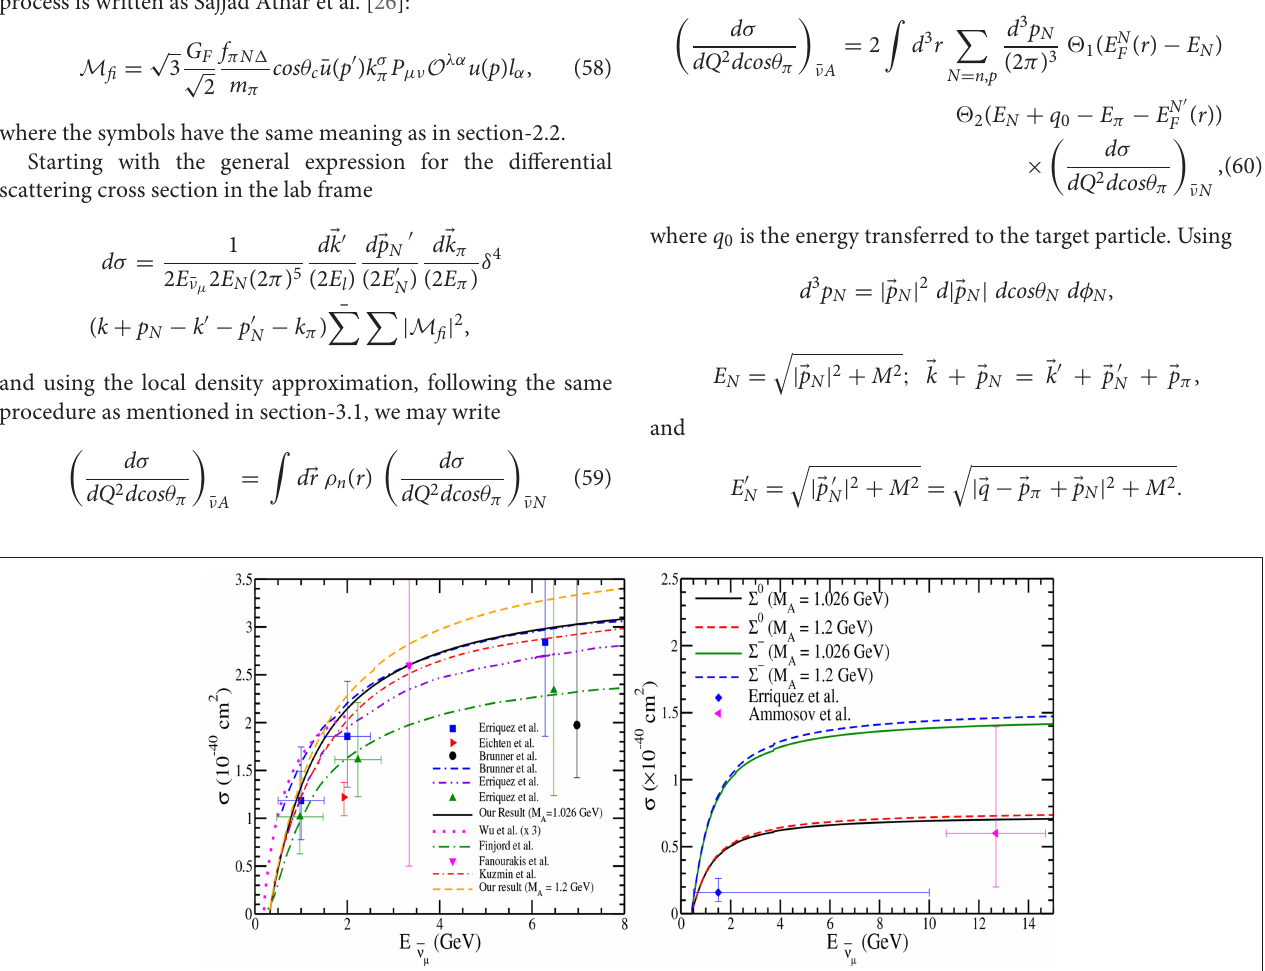
FIGURE 3 | σ vs. E ν µ for the 3 production (left) , 6 0 and 6 − production (right) cross sections. Solid (dashed) line represents the result using M A = 1.026 (1.2) GeV. ¯ ν µ p µ + 3 (triangle right [60], triangle up [59], square [61], triangle down( σ Experimental results for the process ¯ → ν µ p µ + 6 0 (diamond [ 59]) are shown with error bars. Theoretical curves are of Kuzmin and Naumov [68](double dashed-dotted line), Brunner process ¯ → et al. [65](dashed line), Erriquez et al. [61](dashed-double dotted line) obtained using Cabibbo theory with axial vector dipole mass as 0.999, 1.1, and 1 GeV, respectively, while the results of Wu et al. [ 84](dotted line) and Finjord and Ravndal [55](dashed dotted line) are obtained using quark model.